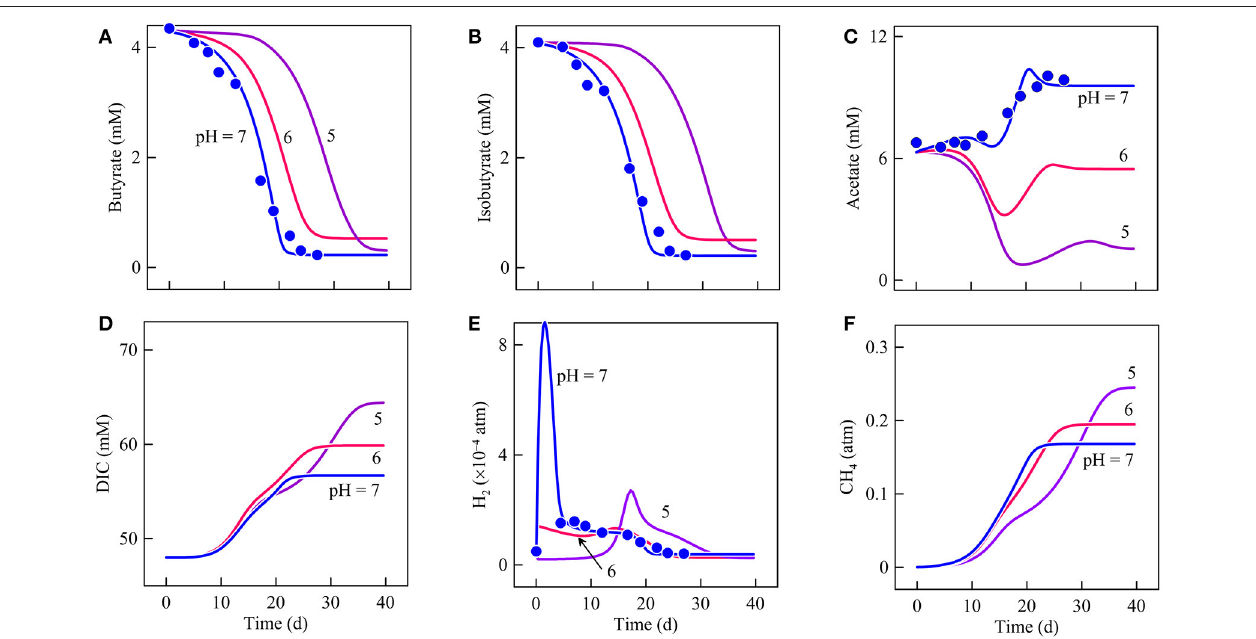
FIGURE 5 | Variation with time in the concentrations of butyrate (A) , isobutyrate (B) , acetate (C) , dissolved inorganic carbon (DIC, D ), and the partial pressures of H 2 (E) and methane (F) in batch reactors of differ pHs. Data points are the results of Wu et al. (1994); lines are the results of biogeochemical reaction modeling, accounting for the impact of pH on the energy available from microbial